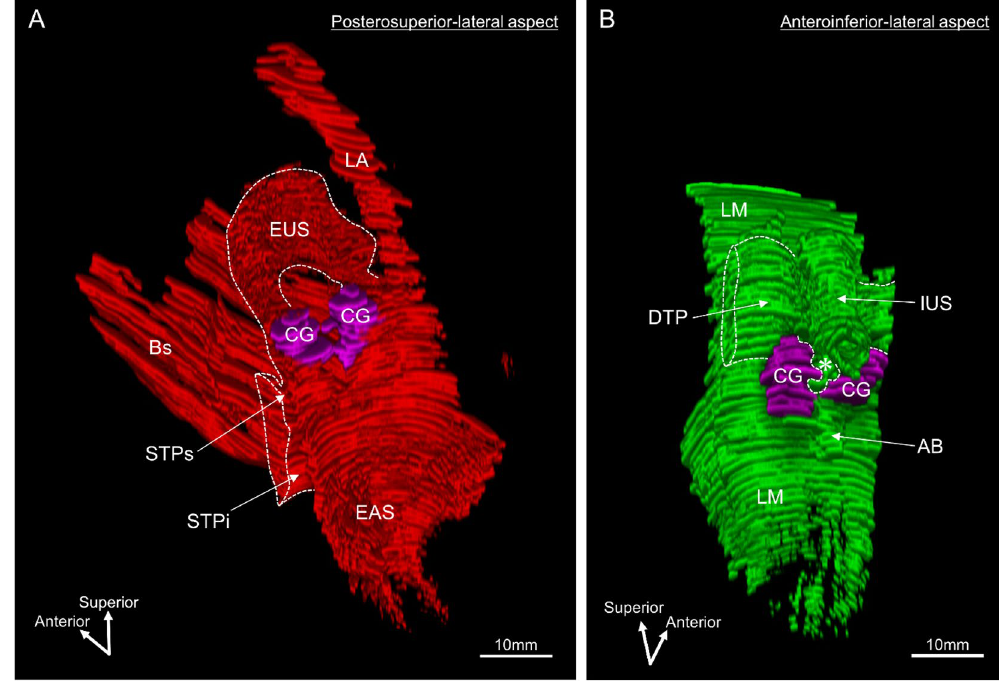
Figure 6. Three-dimensional reconstruction images showing the Cowper’s gland and surrounding muscles. ( A ) The CG (purple) and striated muscles (red) visualized from the posterosuperior-lateral aspect. The CG was laterally covered by the striated muscle of the STPs. The STPs was anterosuperiorly continuous with the EUS. The LA and EAS were continuous with the EUS. ( B ) CG (purple) and smooth muscles (green) visualized from the anteroinferior-lateral aspect. The DTP formed a plate-like wall posterosuperior to the CG. The area between the bilateral CGs was filled with smooth muscle continuous with the DTP (asterisk). The images were created using the SrfII software (ver. R.11.00.00.0-H, Ratoc, Tokyo, Japan, http:// www. ratoc. com/ eng/ index. html). AB anterior bundle of the LM, Bs bulbospongiosus, CG Cowper’s gland, DTP deep transverse perineal muscle, EAS external anal sphincter, EUS external urethral sphincter (rhabdosphincter), IUS internal urethral sphincter, LA levator ani, LM longitudinal muscle, STP superficial transverse perineal muscle, STPi inferior bundle of the STP, STPs superior bundle of the